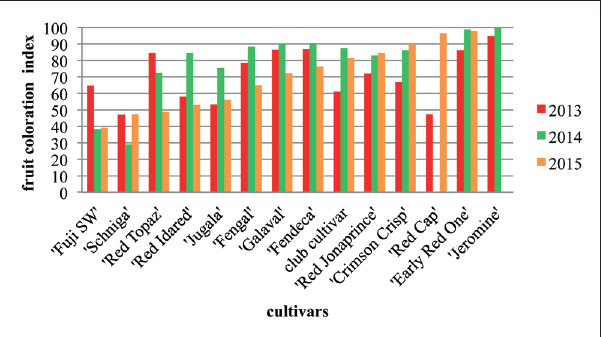
Figure 2 : Fruit coloration index of apple cultivars (Nyírbátor, 2013-2015).